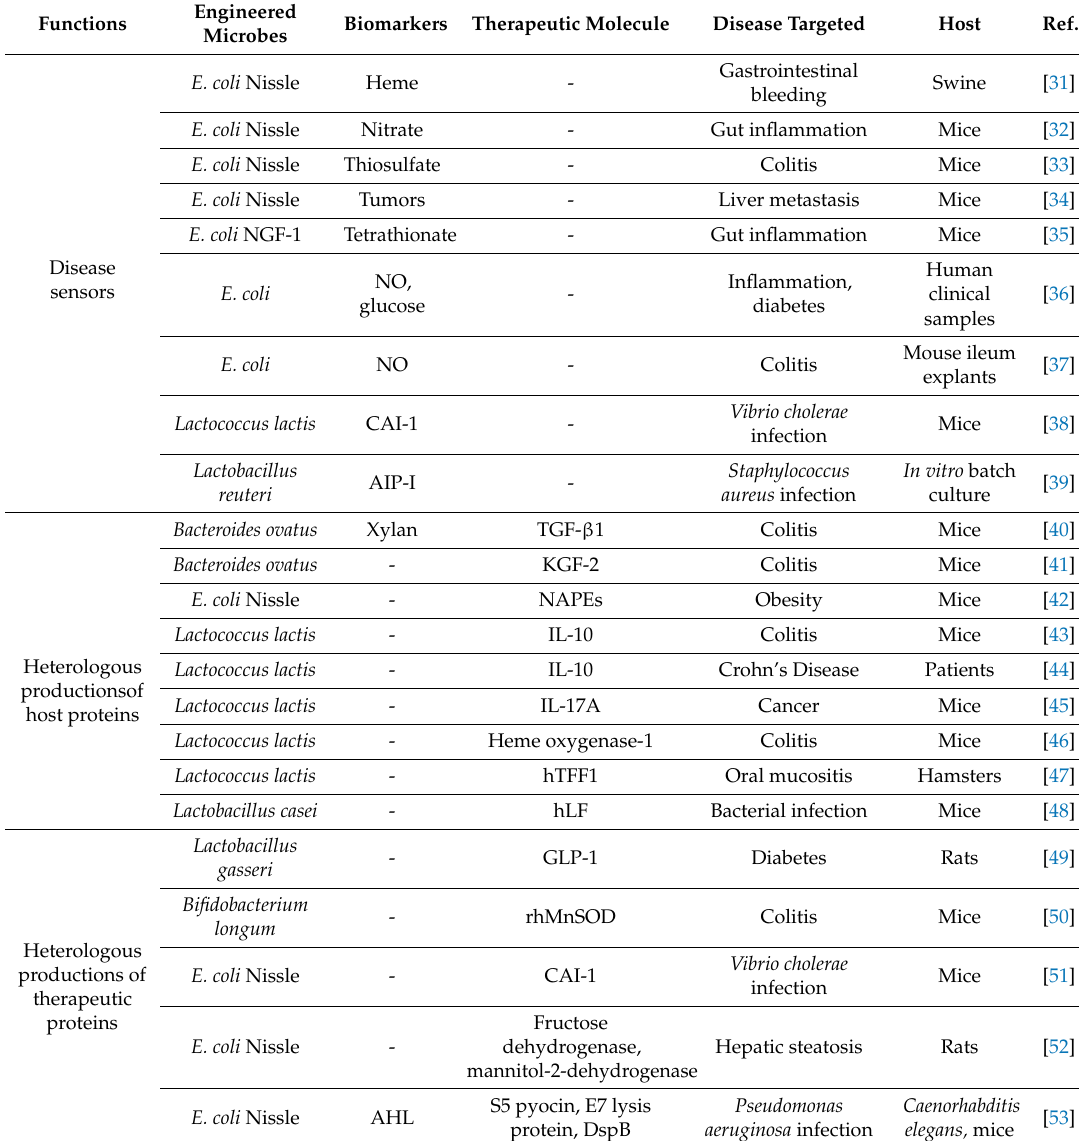
Table 1. Therapeutic functions of engineered